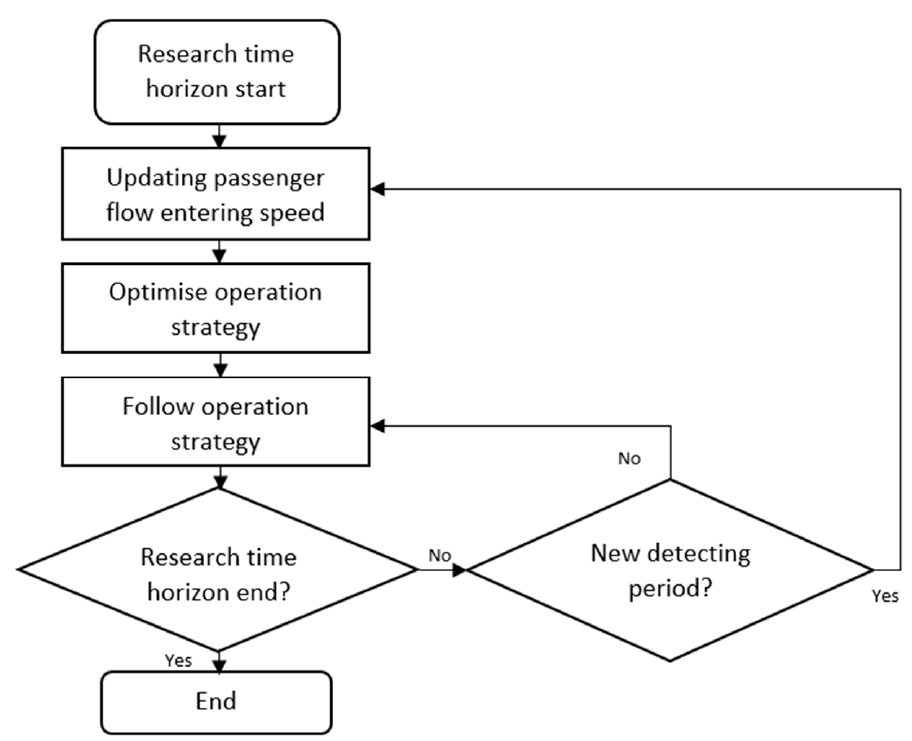
Figure 2. Real-time, passenger-oriented operation method (RPOM) process. Based on the Field Study in the London Underground Bakerloo Line Operation De- partment, Modifying the Number of Trains in a Specific Operation Time Horizon Will Severely Affect the Economic Operation of the Metro System and Lead to More Operation Problems, such as the Staffs’ Redeployment. Thus, the Number of Trains Active in the Research Time Horizon Is Fixed for in this Research.